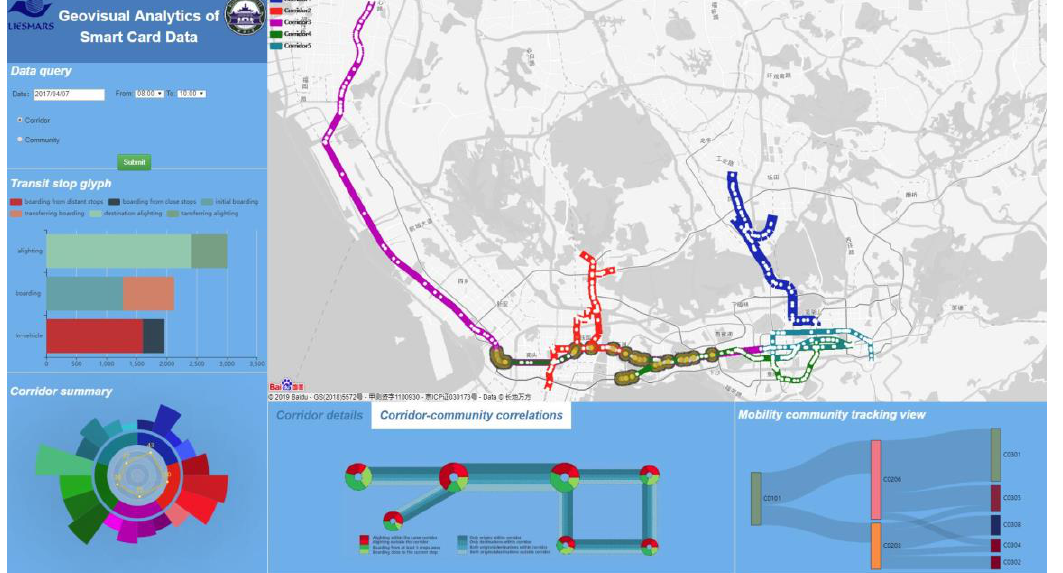
Figure 10. Web-based prototype user interface.